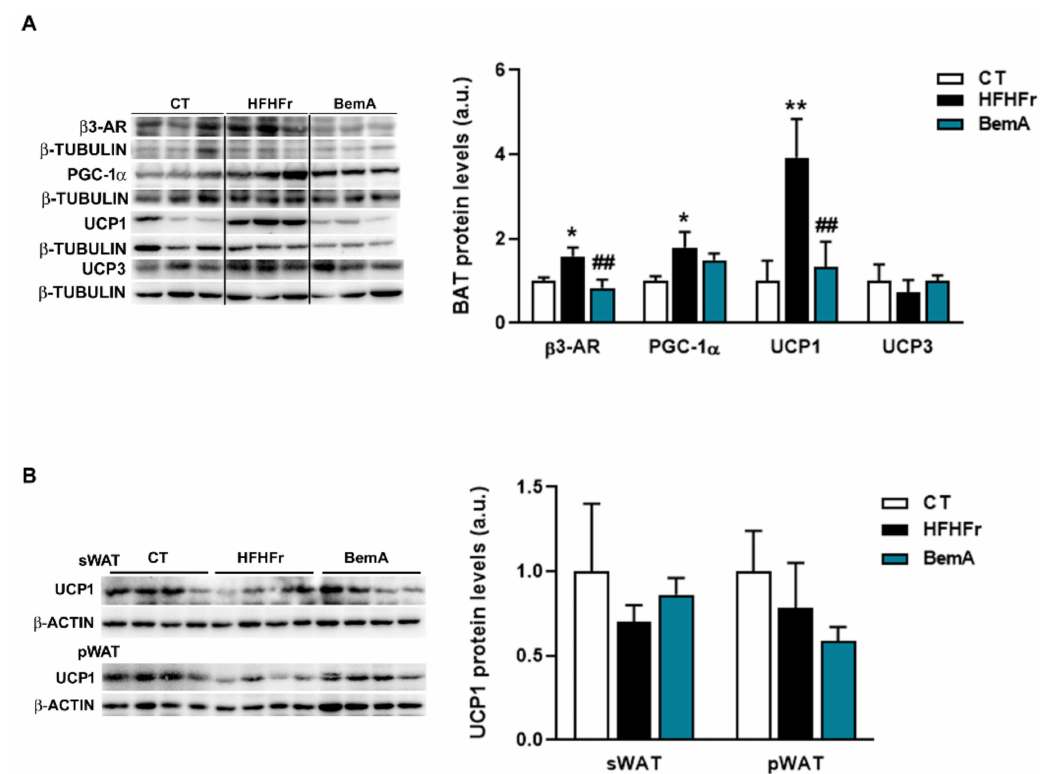
Figure 1. Bempedoic acid does not increase thermogenic activity in adipose tissue. Protein levels of β 3-AR, PGC-1 α 2, UCP1, and UCP3 in brown adipose tissue ( A ) and of UCP1 in subcutaneous adipose tissue (sWAT), and perigonadal white adipose tissue (pWAT) ( B ) from control (CT), high-fat, high-fructose (HFHFr), and bempedoic acid (BemA)-treated rats. The results are expressed as the mean ± SD of four pooled samples for each condition, obtained by mixing equal amounts of tissue from two rats. On the left side of the figure, representative Western blot bands corresponding to the three different study groups are shown. a.u.: arbitrary units. Data were analyzed by one-way ANOVA, followed by Tukey’s post-hoc test. * p < 0.05, ** p < 0.01 compared to CT; ## p < 0.01 compared to